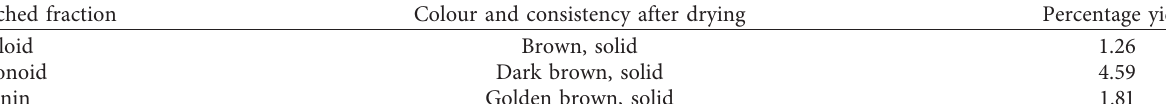
Table 1: Physical properties and percentage yield of three phytochemical-enriched fractions.